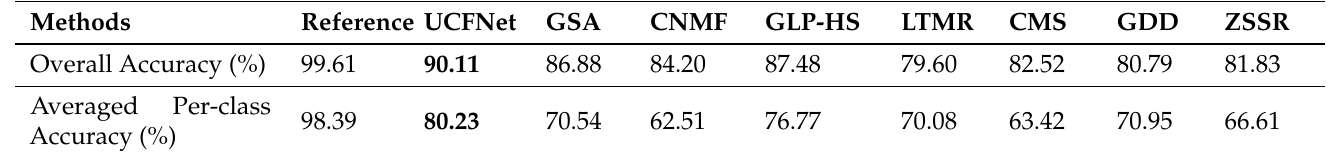
Table 2. Test accuracy of classification results of the compared approaches. The scaling factor is 8. The best performances are highlighted in bold.